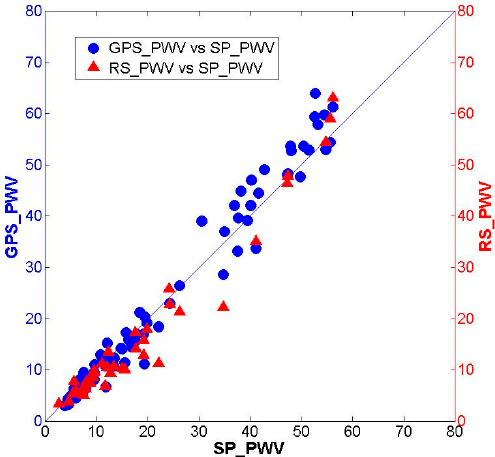
Figure 12. Time series of difference between GPS_PWV NCEP and NCEP_PWV ( blue line) and ratio between observation numbers of L1 and L2 ( red line).